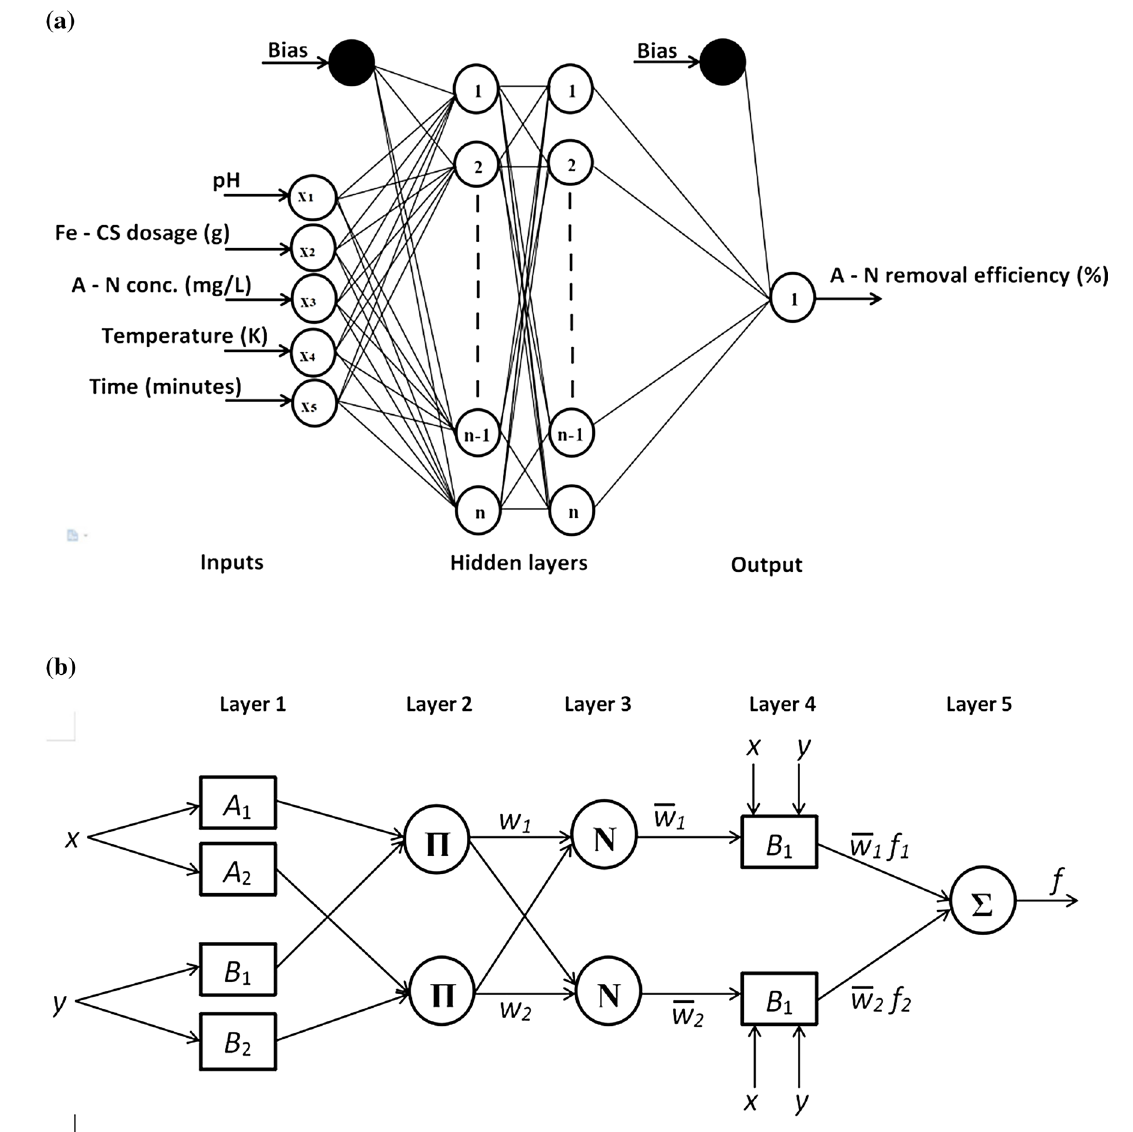
Fig. 1 Architectural framework of a ANN b